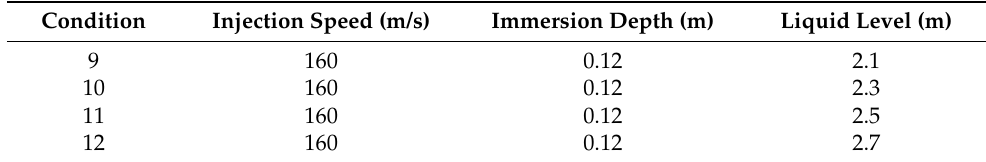
Table 4. Parameters of different liquid level working condition groups.